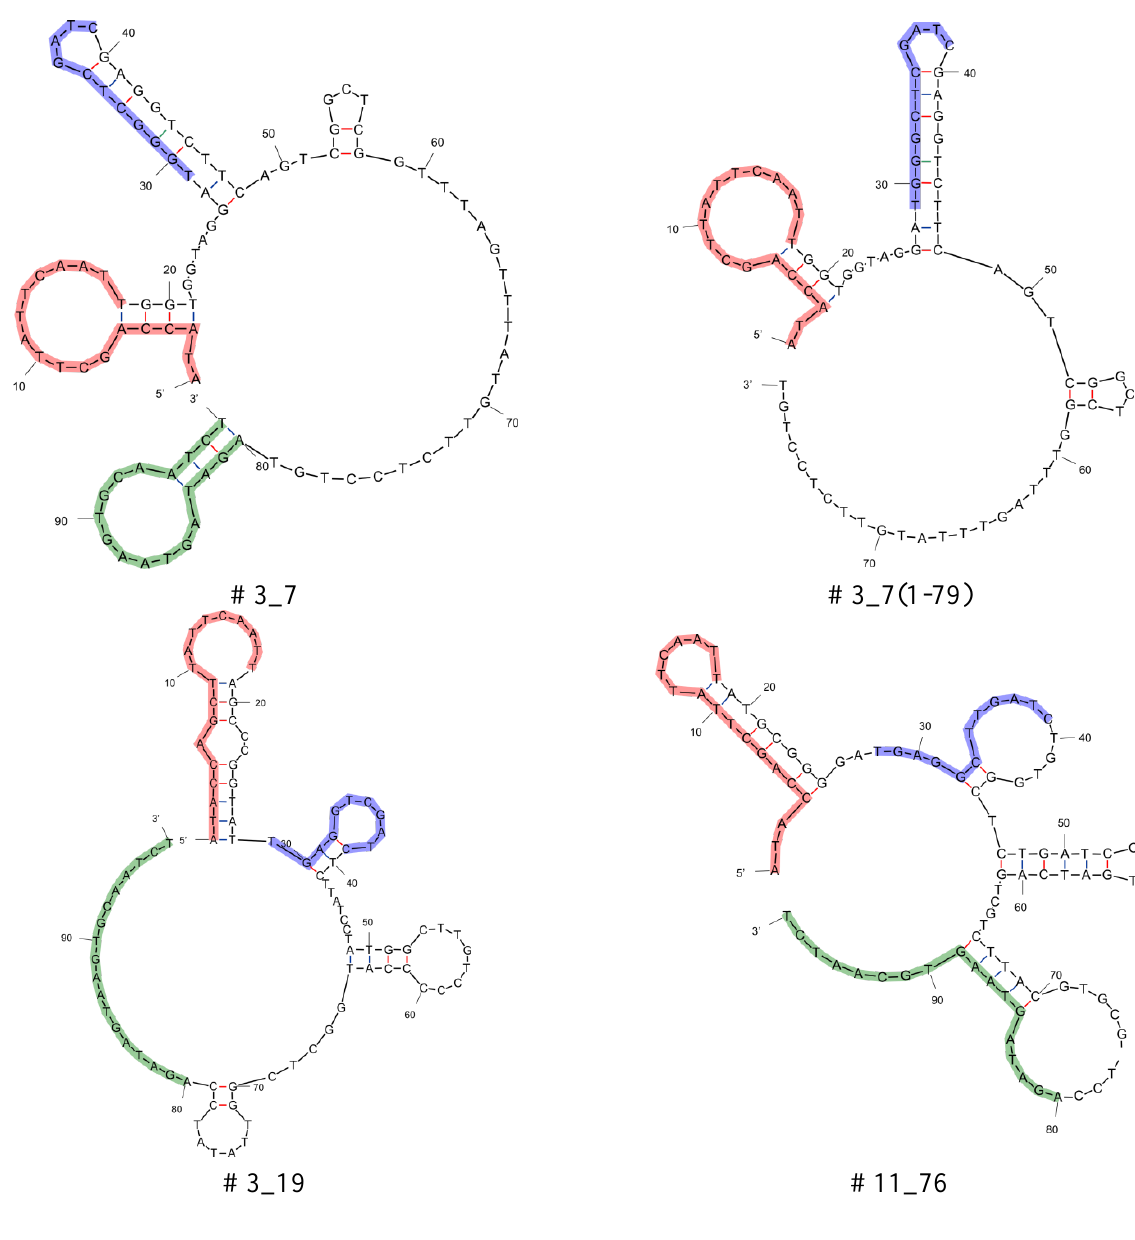
Figure 2. Secondary structures of selected aptamers and truncations. The 5' and 3' primer binding sites are highlighted in red and green, respectively. The docking sequence is highlighted in